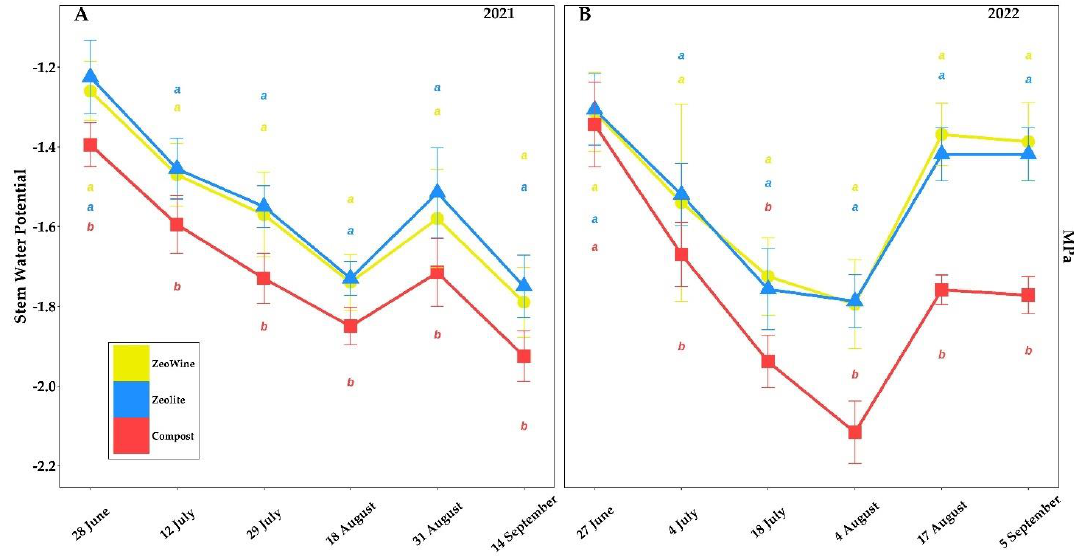
Figure 5. Physiological parameters (quater). Stem water potential ( Ψ stem) of Vitis vinifera with three different soil management treatments. Measurements were conducted from June to September (( A ) 2021 and ( B ) 2022). Data (mean ± SE, n = 10) were subjected to one-way ANOVA. The bars represent the standard deviation. Different letters indicate significant differences between Zeowine, Zeolite, and Compost (LSD test, p ≤ 0.05).